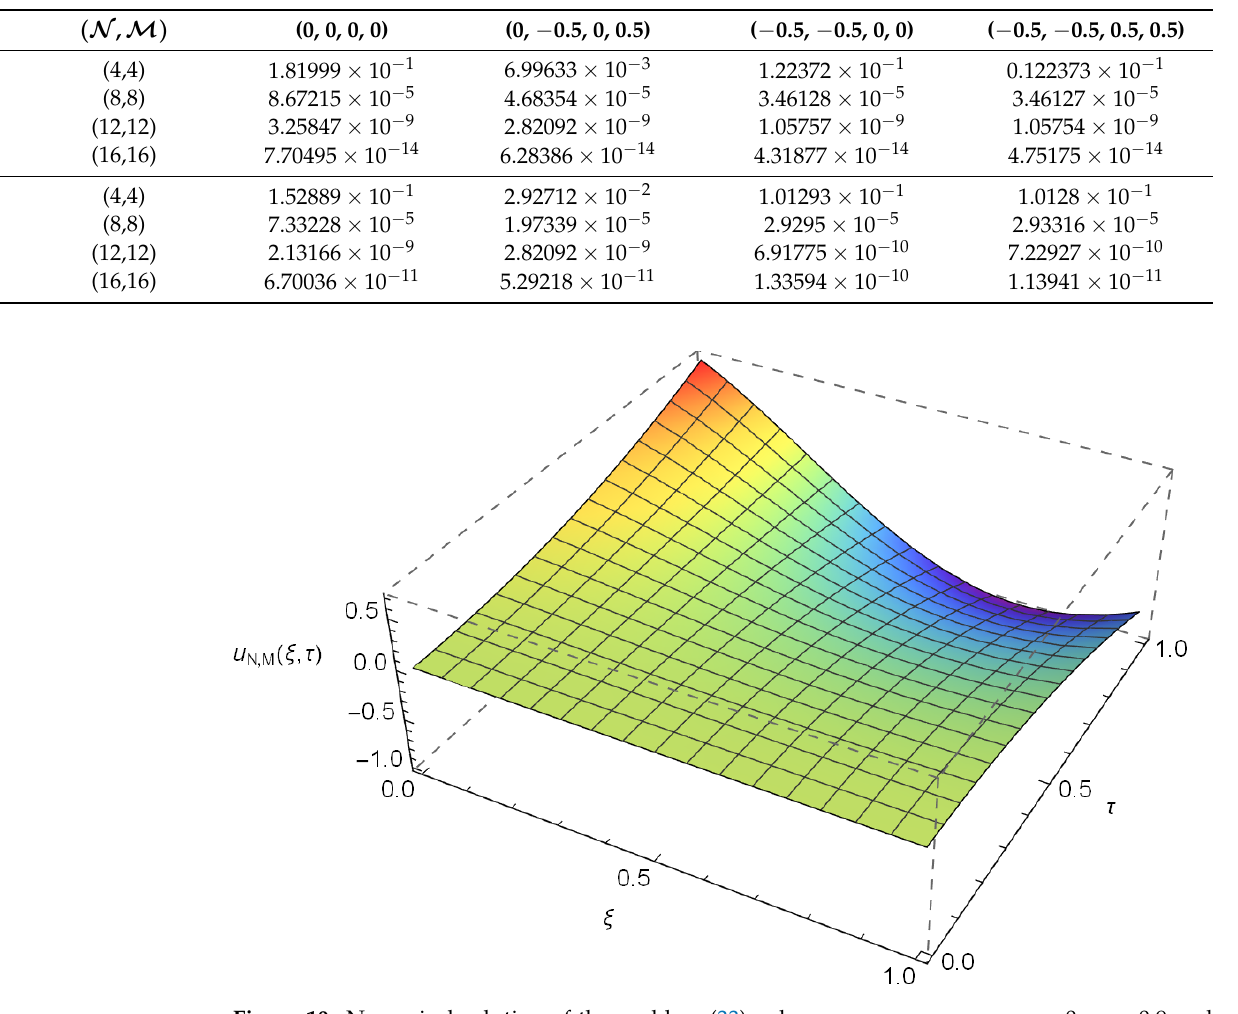
for problem (33). Q